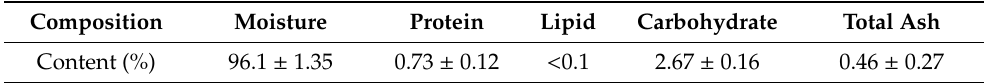
Table 1. Composition of the fresh white radish.